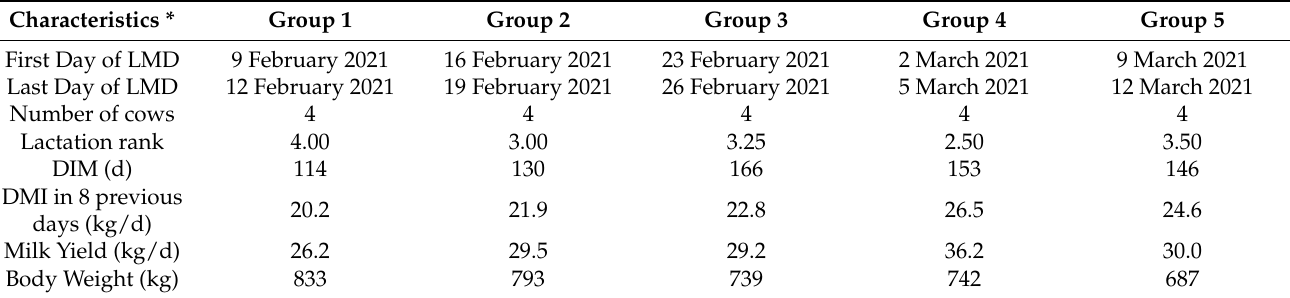
Table 1. Animal characteristics and methane measurement dates for the group of cows involved in the methane measurements